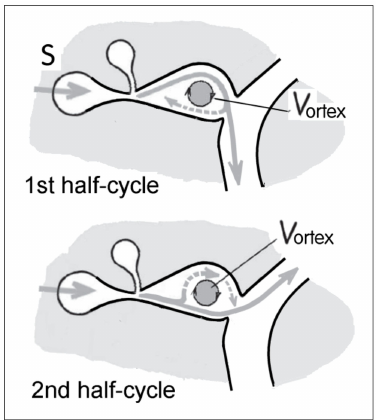
Figure 21. Very high frequency fluidic oscillator [25] with a single permanently rotating vortex kept captive in the pre-chamber. This amplifier, of not large size (nozzle exit b × h = 1.191 mm × 2 mm) oscillated at a frequency as high as 8.23 kHz. Both jet deflections are unstable: in the first half-cycle it Coanda attachment is eliminated by inflow from atmosphere through the control nozzle, while in the second half-cycle, it is opposed by rotation of the